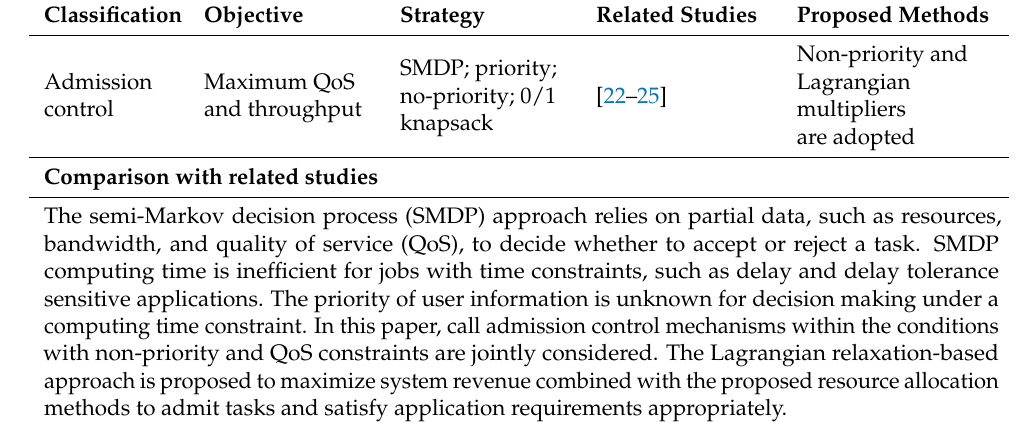
Table 3. Admission control comparisons with existing methods. Classification Objective